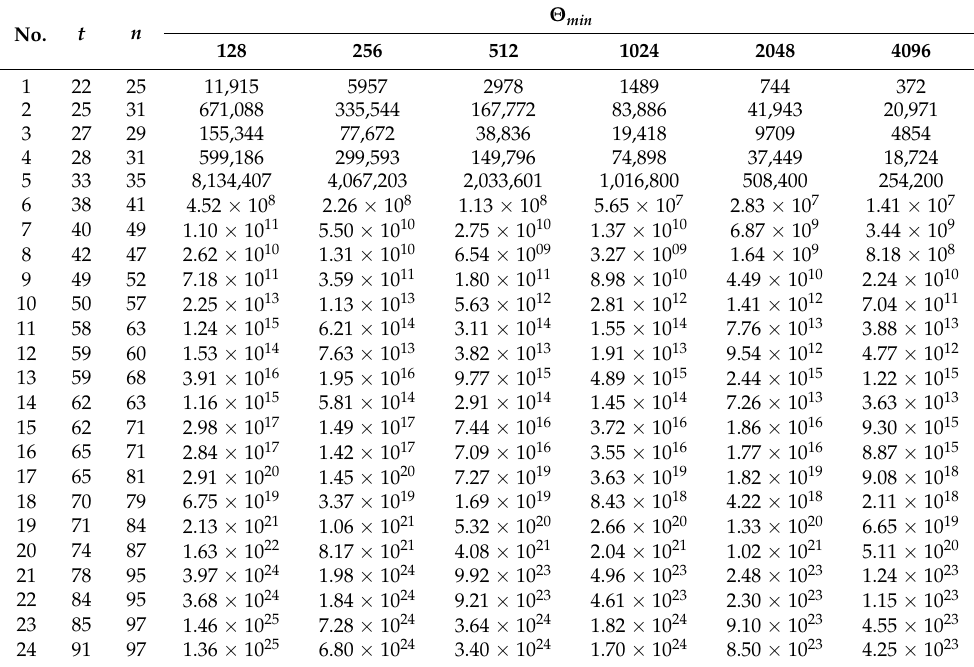
Table 2. The number of scan paths to be fed with test sequences from a TPG designed as a set of DT-LFSR registers, with consideration of various phase shift Θ min